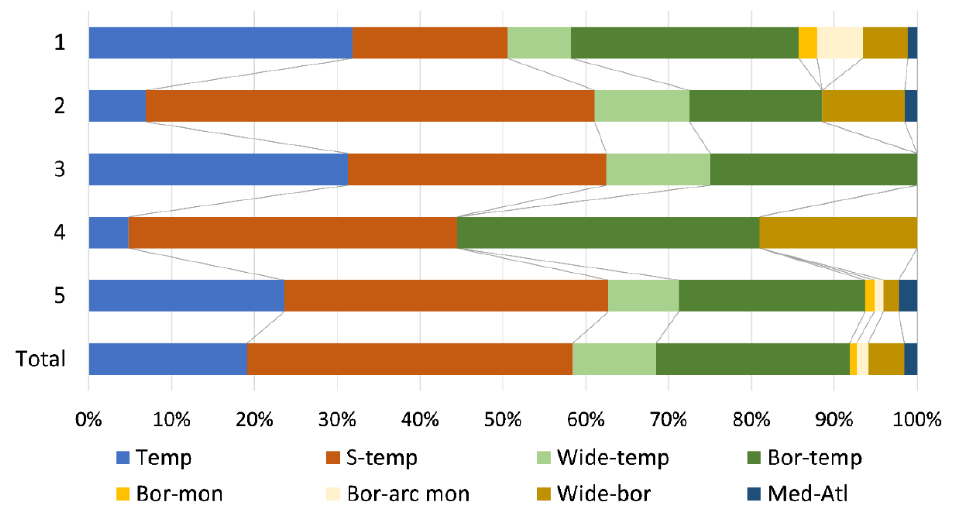
Figure 5. Chorological spectrum of freshwater bryophytes based on major biomes for TWINSPAN groups and a total sample of 76 bryophyte-dominated sites.